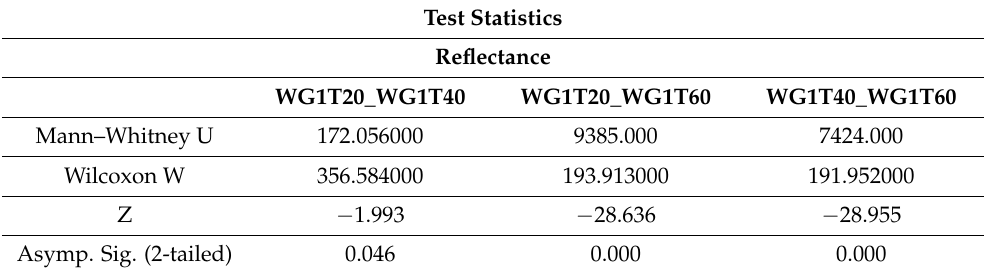
Table A16. Test statistics table of Mann–Whitney U test for specular solar reflectance of WG1 during the three holding times.